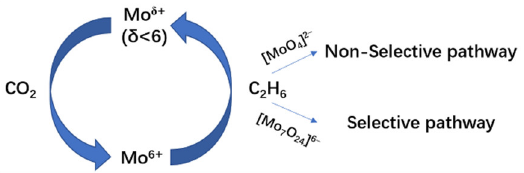
Figure 9. The reaction pathway of ODHE over the Mo/LDO catalyst. Table 3. The detail of catalytic performance over the Mo/LDO catalysts.